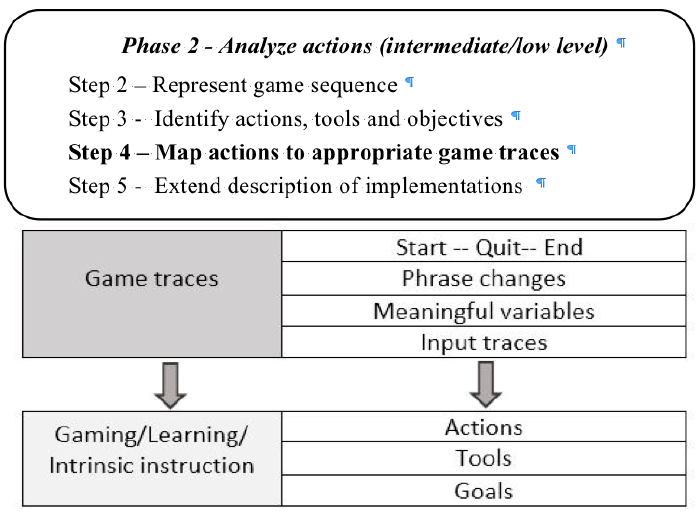
Fig. 3. Extended hierarchical analysis mapping actions to